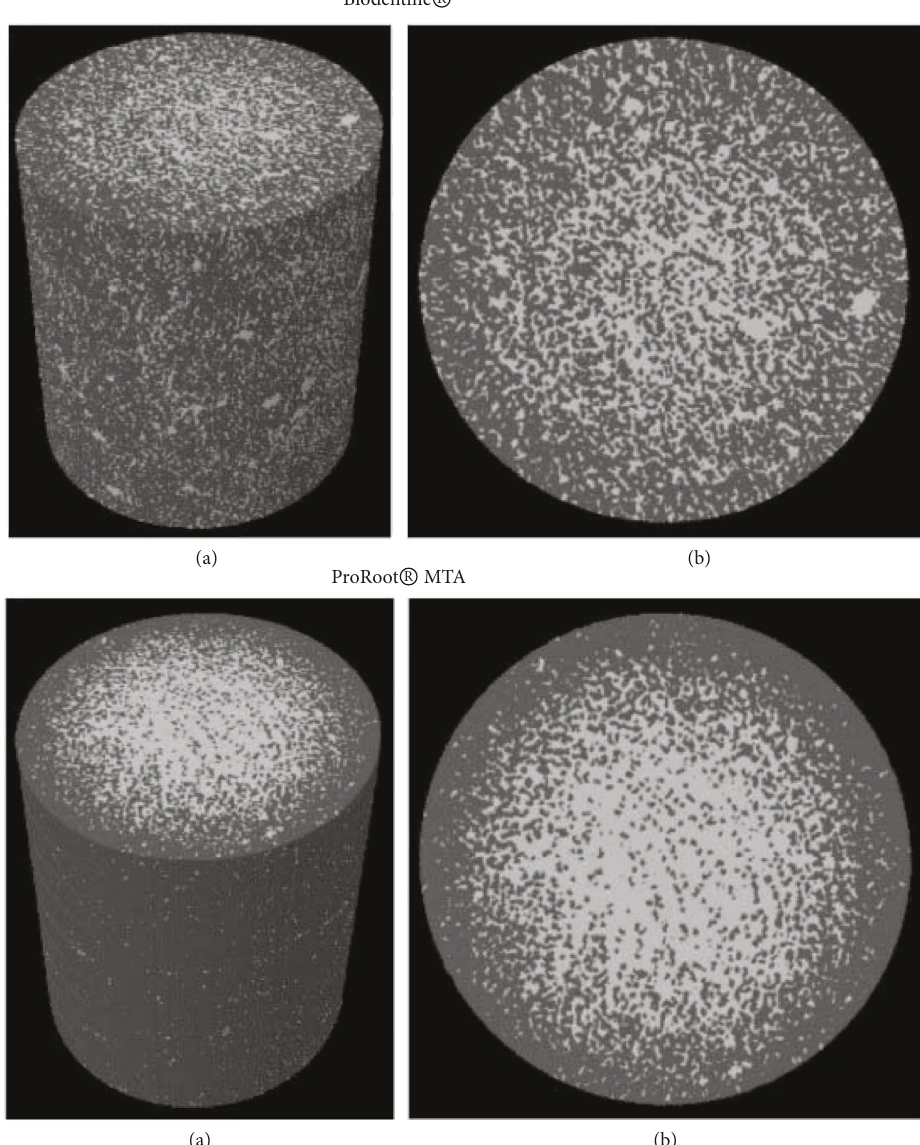
Figure 3: Micro-CTgraphs indicating porosity of Biodentine ® and ProRoot ® MTA. (a) A 3D model in the presence of endodontic material and porosity. (b) A cross section demonstrating repair material and porosity of Biodentine ® and ProRoot ® MTA. Pores are marked with the white color, while repair materials without porosity appear in